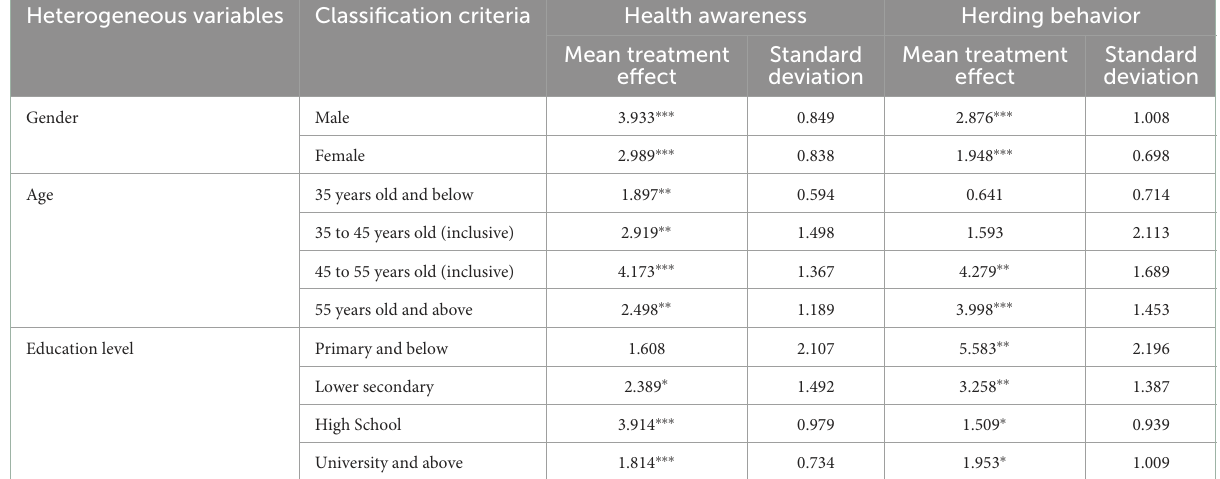
TABLE 7 Results of heterogeneous group